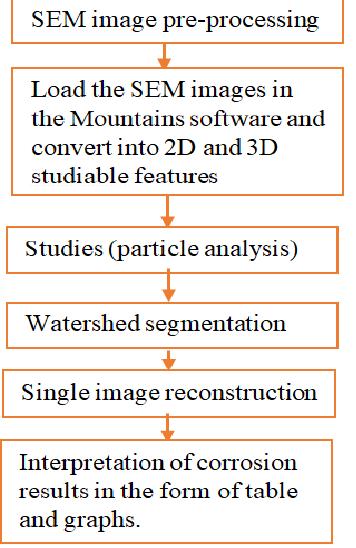
Figure 3. Procedures of image processing.